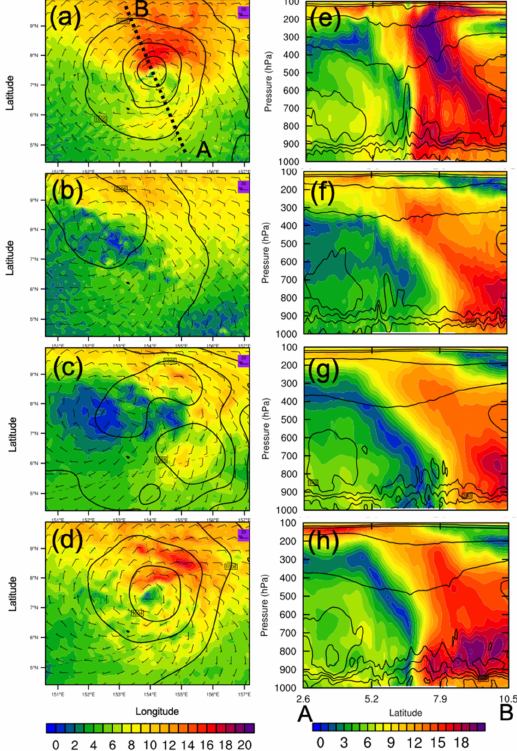
Figure 8. Surface wind vector, wind speed (shaded), and sea level pressure (black line) for ( a ) the nature run, ( b ) the control run, ( c ) the DA_CONV, and ( d ) DA_CONV_MURON analy- sis valid at 1800 UTC 3 November 2013. Vertical cross section of wind (shaded) and equivalent potential temperature (black solid contour) of a south to north vertical cross-section for ( e ) the na- ture run, ( f ) the control run, ( g ) the DA_CONV, and ( h ) the DA_CONV_MURON analysis valid at 1800 UTC 03 November 2013. The dotted line across the TC center in ( a ) denotes the corresponding cross-section in ( e – h ).